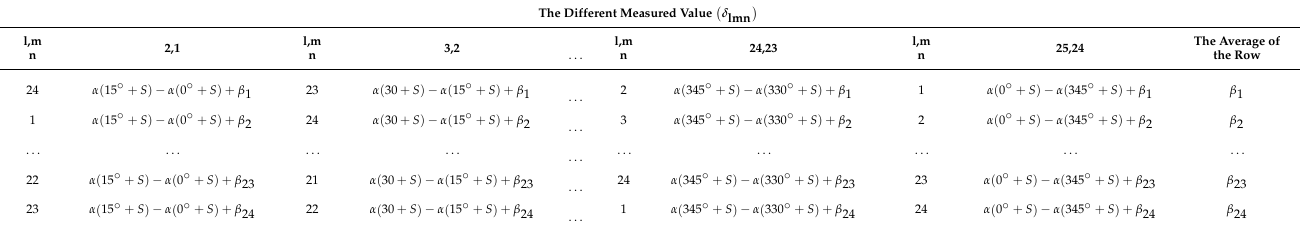
Table 2. Shift-angle method for